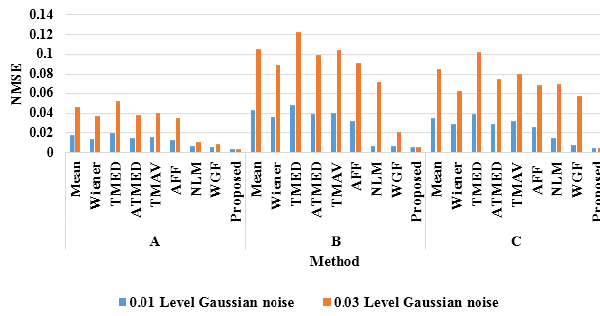
Figure 11: Graphical comparison of NMSE value (0.01 and 0.03 Level Gaussian